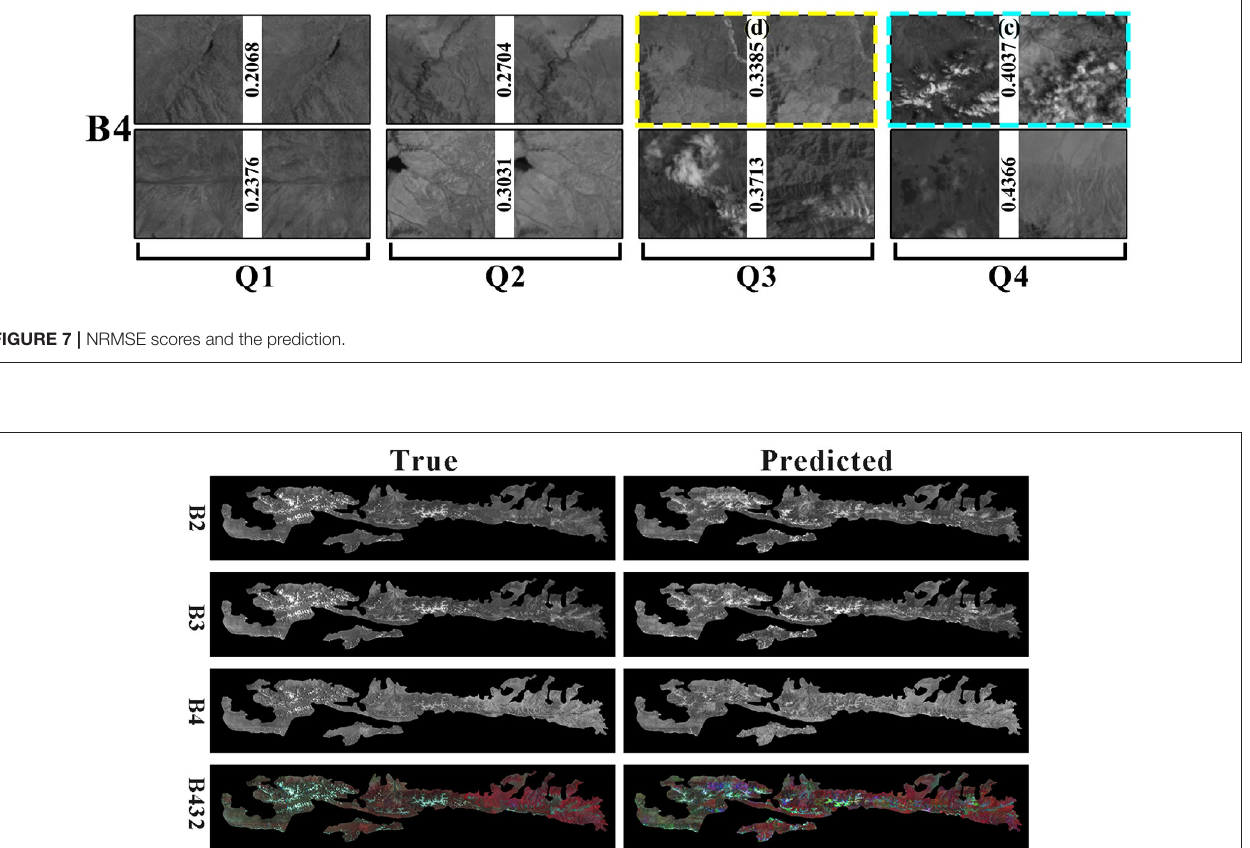
The final result comparison is shown in Figure 8